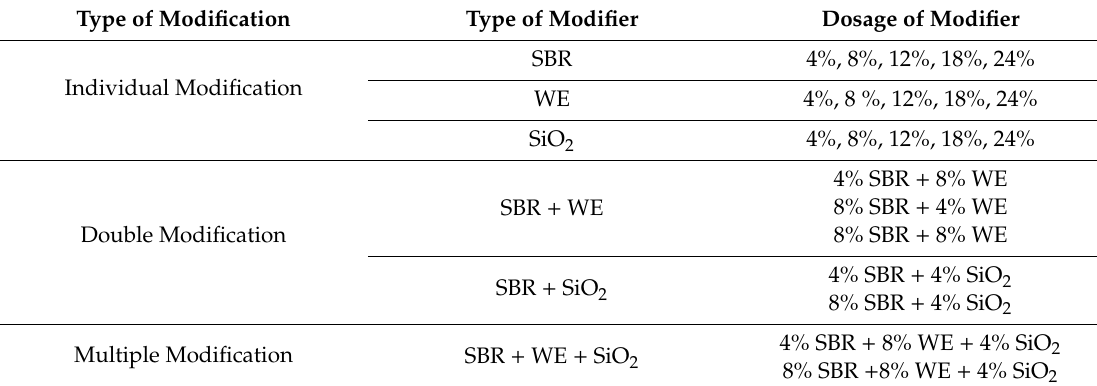
Table 1. Summary of modifier dosages for various types of modified bitumen